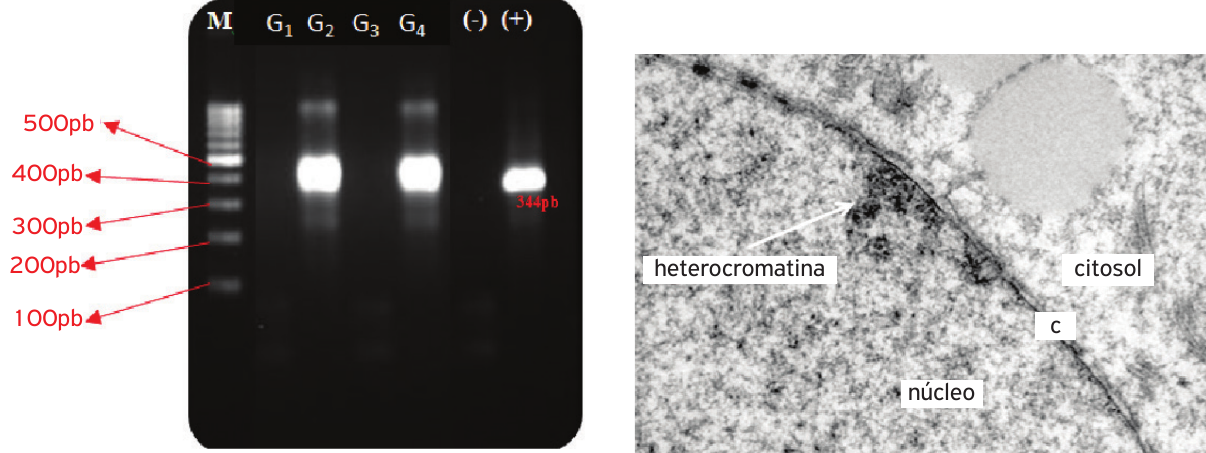
Figura 8. Nested PCR. M: padrão de peso molecular DNA ladder de 100 pb; G : controle; G : exposto aos vírus; G : exposto ao Figura 11. Embrião do grupo controle G1. Em destaque 1 2 3 extrato etanólico da casca de Punica granatum ; G : exposto aos hetreocromatina (seta); C: carioteca íntegra. Aumento: 4 vírus e ao extrato etanólico da casca de Punica granatum ; (-): 30.000x. controle negativo; (+): controle positivo.